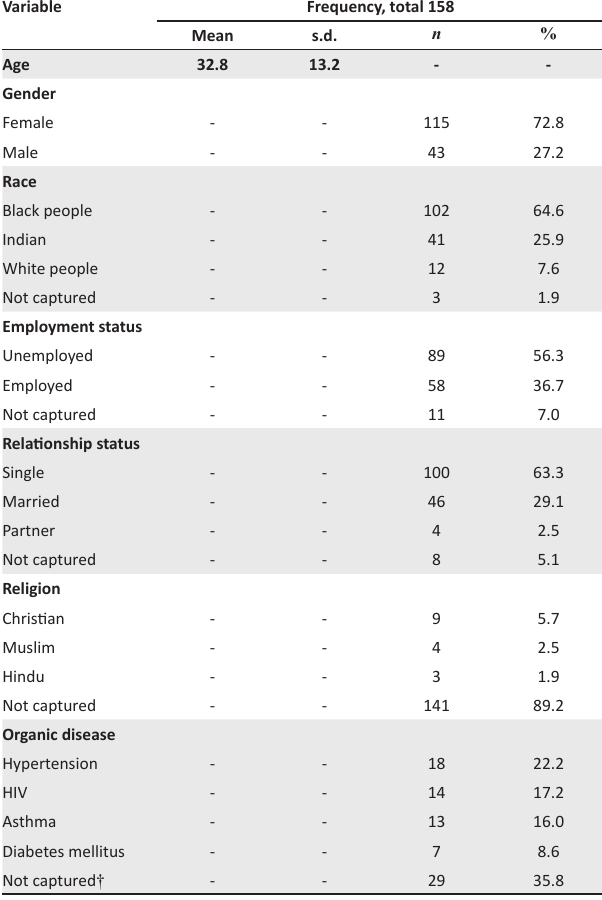
TABLE 1: Patient demographics and clinical characteristics. Variable